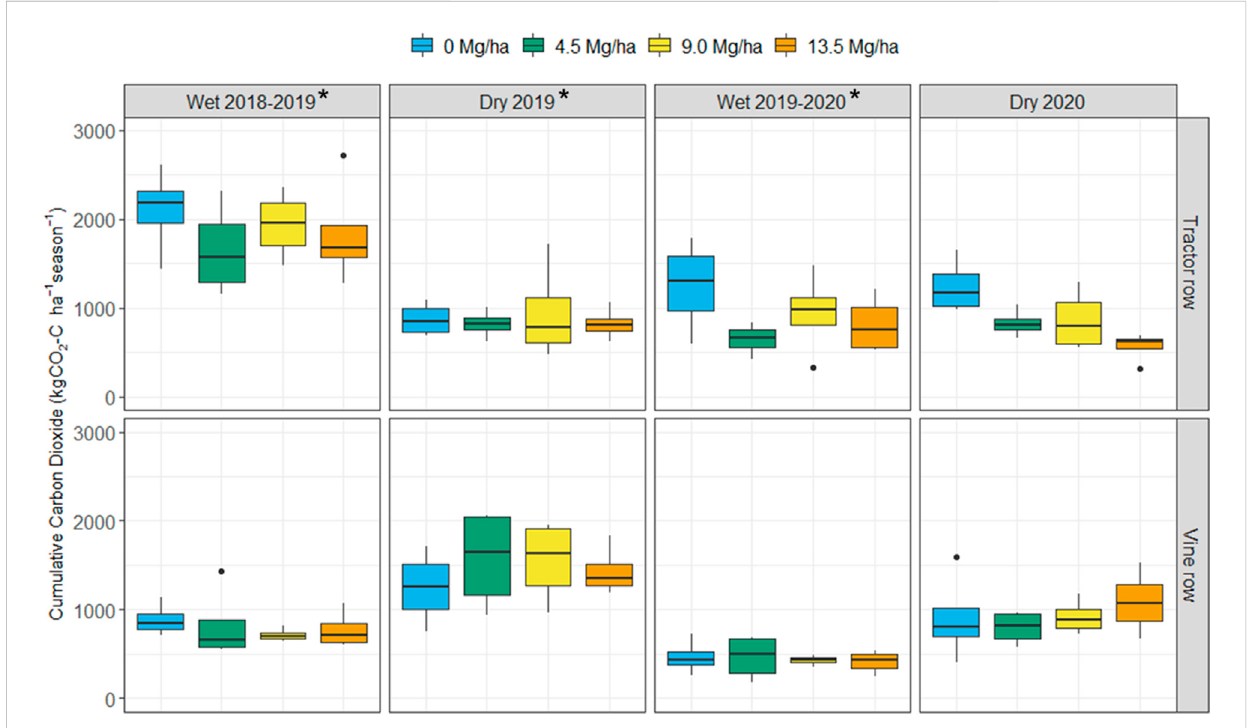
FIGURE 7 Cumulative CO 2 emissions by functional location under compost application treatments (0, 4.5, 9.0 and 13.5 Mg ha -1 ) during two wet and two dry seasonsfrom2018to2020.Errorbarsrepresentstandarderrorsofthemean(n=4).Asterisks(*)indicatesigni fi cantdifferencesbetweenlocationswithin the same season and application rate at p < 0.05.